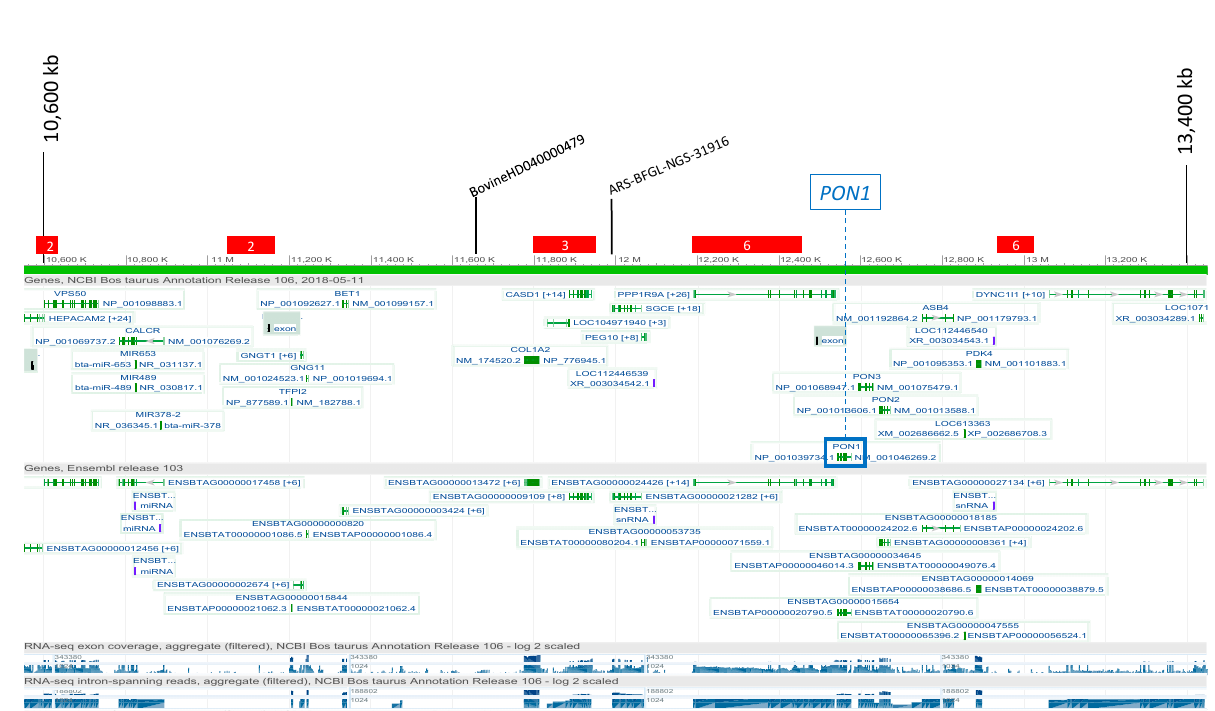
Figure 2. Association signals on BTA4 for paraoxonase. Single SNPs with SNP names are indicated and HaploBlocks are indicated as rectangles containing the number of overlapping HaploAlleles in the significant region. SNP markers and haploblocks are indicated: Black = Italian Holstein; red = Italian Simmental. The location of the paroxonase-1 gene ( PON1 ) is indicated in the blue box.